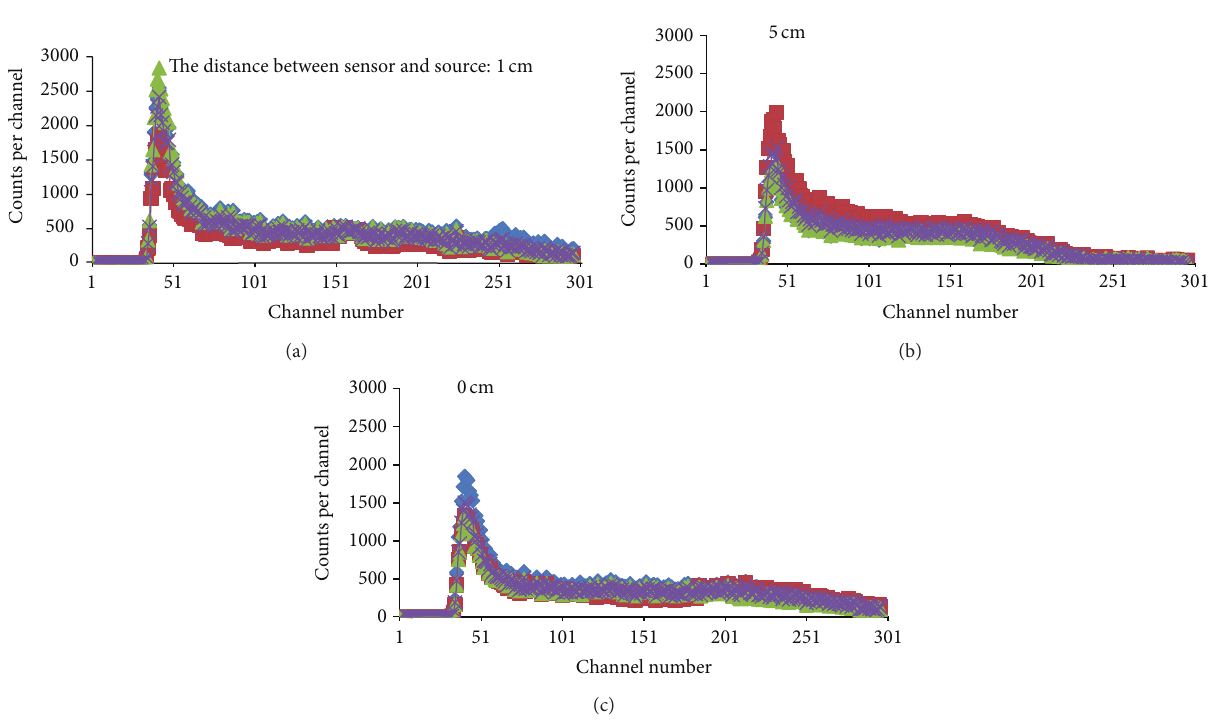
Figure 4: Reproducibility evaluation on the distance between the radiation sensor and the